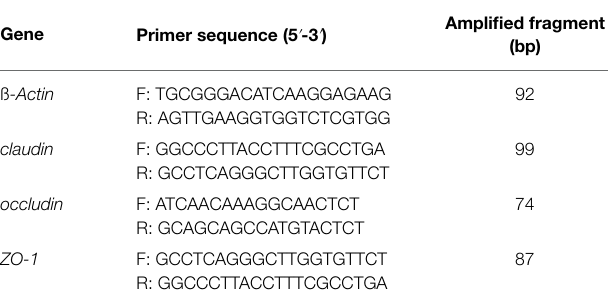
TABLE 1 | Primer sequences for genes amplified in this study. F, forward primer; R, reverse primer. Gene Primer sequence (5 ʹ -3 ʹ )